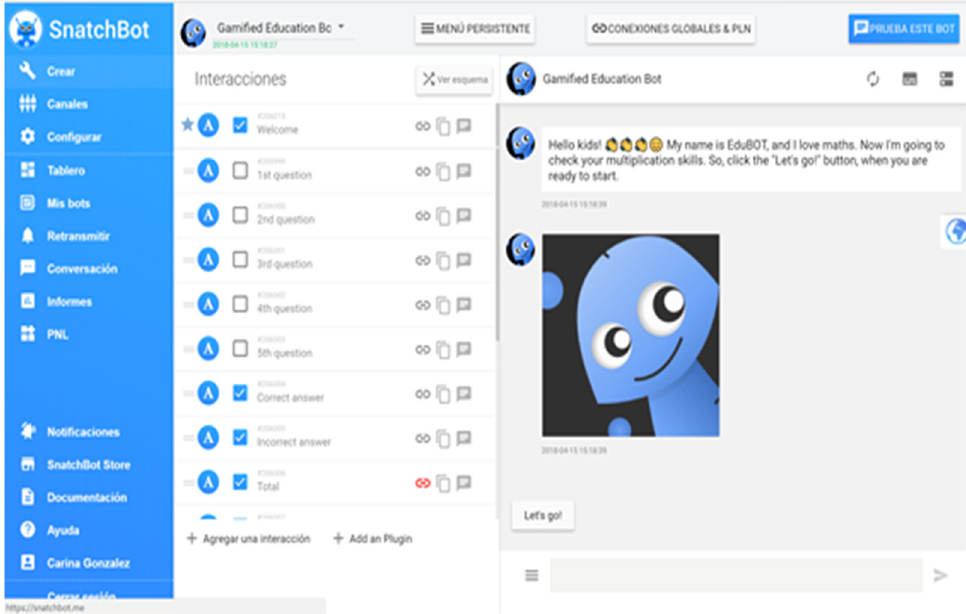
Figure 3. An example of an educational bot to practice mathematics.